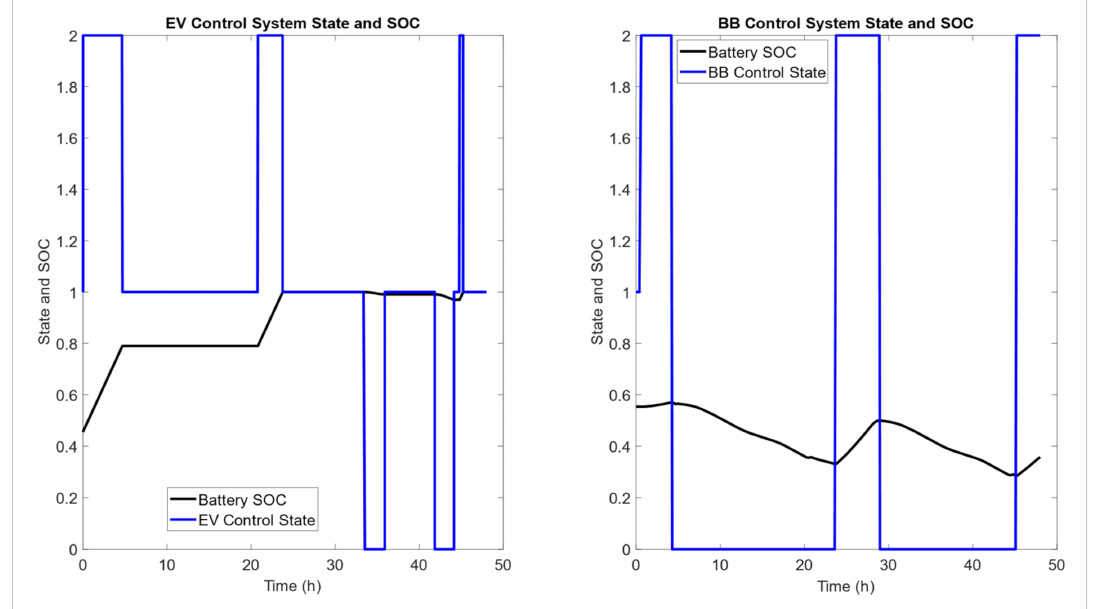
Figure 18. System state and Battery SOC the ( left ) EV converter, ( right ) battery bank. Finally, the DC bus voltage and the energy supplied (positive) and absorbed from the battery of the EV and battery bank are shown in Figure